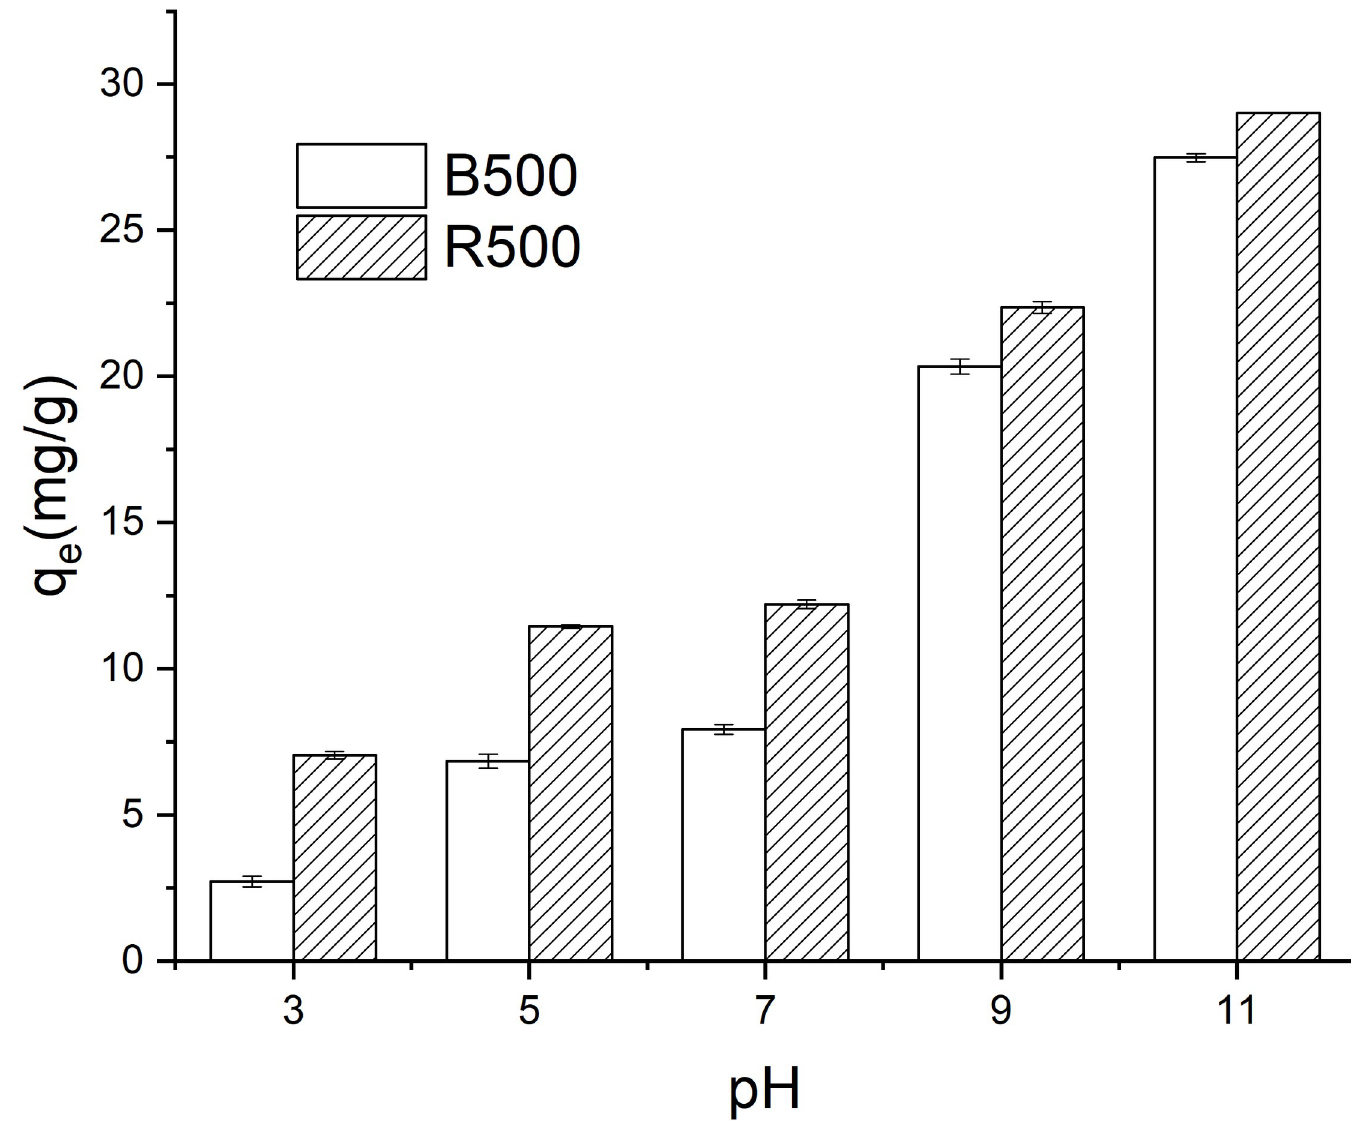
Fig 5. Effect of pH on adsorption capacity of Basic Red 46 on B500 and